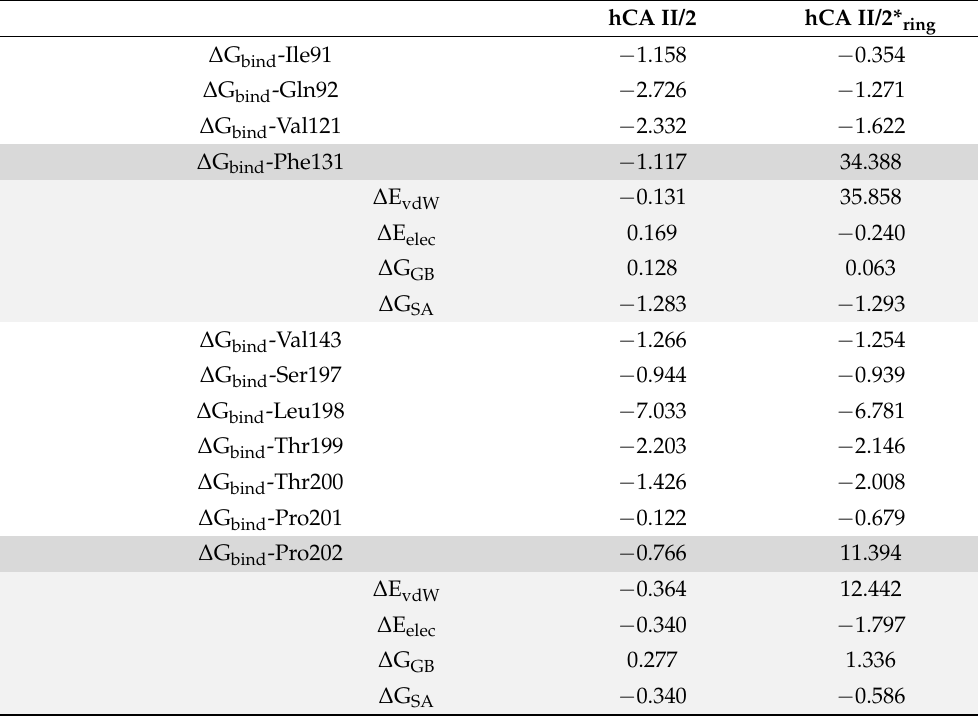
Table 3. Per-residue decomposition of the binding free energy (kcal/mol) computed by the MM/GBSA method for the crystallographic adduct hCA II/ 2 and the model adduct hCA II/ 2* ring .